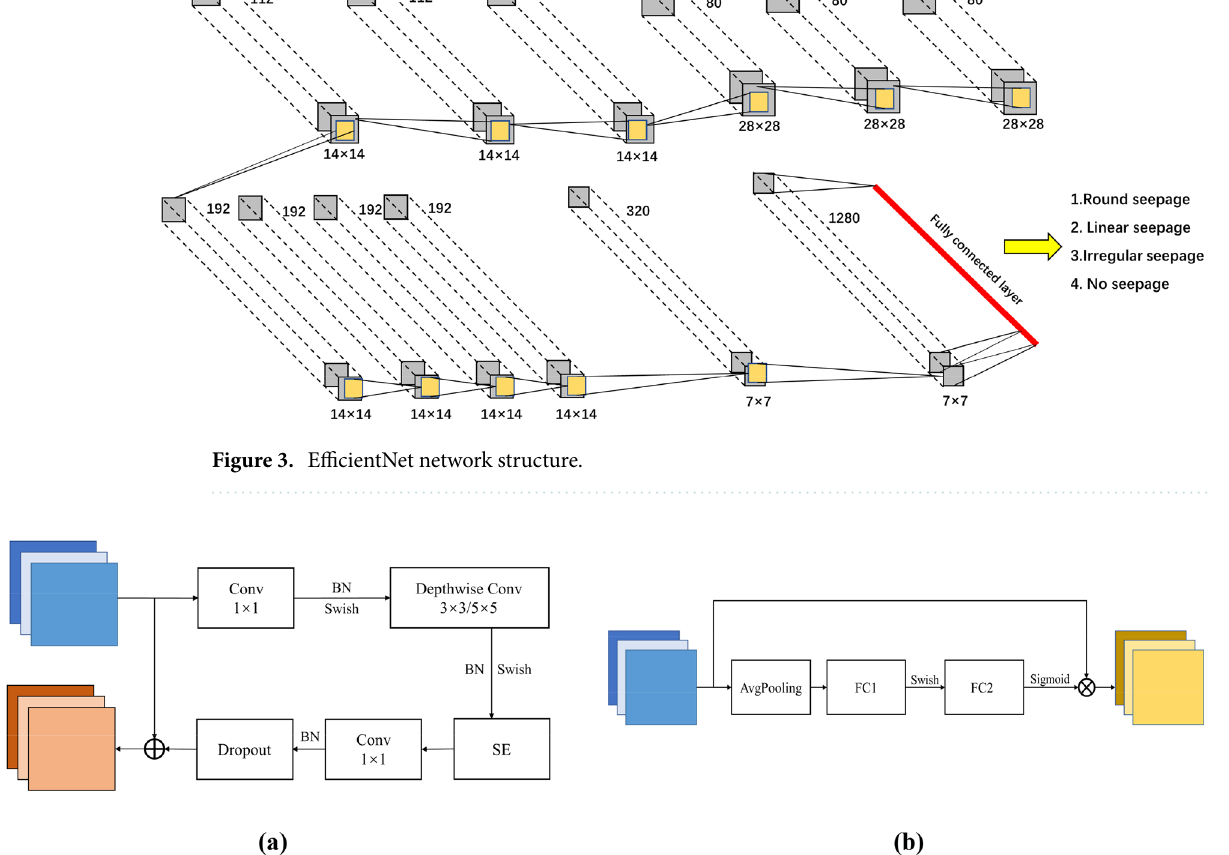
Figure 4. MBConv module and SE module ( a ) MBConv module; ( b ) SE